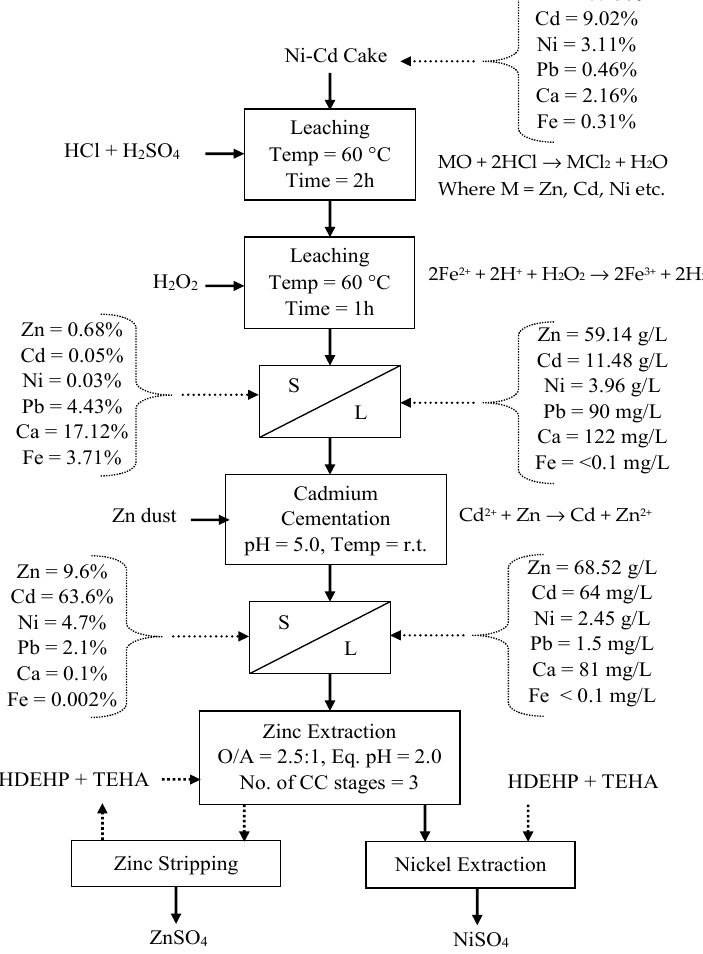
Figure 10. Complete process flowsheet for the recovery of metal values from Ni-Cd cake from an Iranian zinc plant.